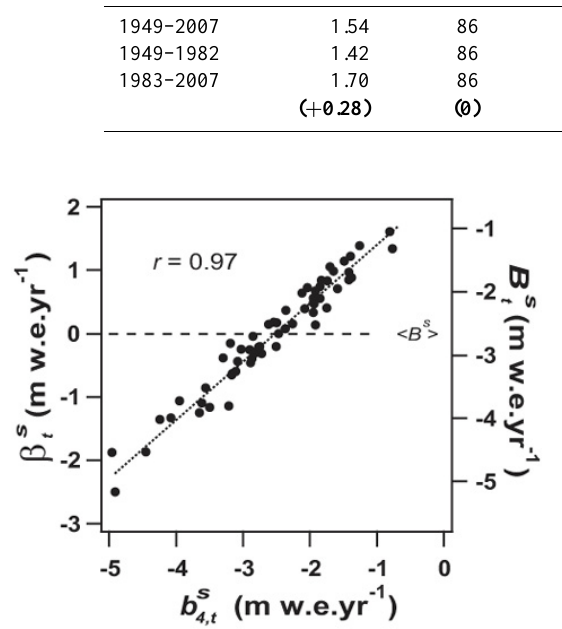
Fig. 8. Selection of a single stake to represent the overall summer centred balance, β s t , or glacier-wide summer balance, B s t . Stake 4 is the best estimator and the summer balance, b s location is highly correlated to the centred summer balance. Over the period of record, (cid:10) B s (cid:11) is − 2.66mw.e.yr − 1